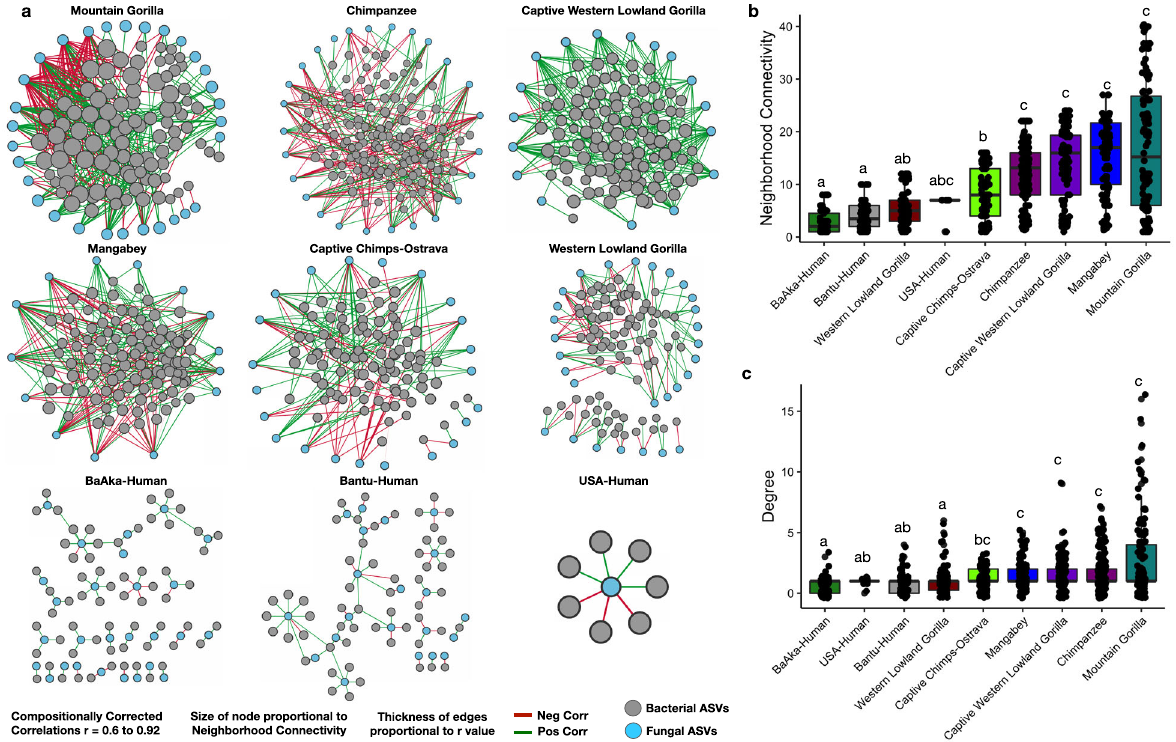
Fig. 4 Complexity of bacteriome-mycobiome co-occurrence networks varies among different primate groups. a Co-occurrence networks constructed using all signi fi cant correlations (compositionally corrected corrs r > + / − 0.6 and p < 0.01) showed clear distinctions in network complexity between human and nonhuman primates. Size of the node shows the number of connections of each fungal ASV. Color of nodes represents bacterial and fungal ASVs shown in Fig. 4a. Each symbol represents an individual primate species. Edge color represents negative (red lines) and positive (green lines) correlations respectively. Bacterial fungal co-occurrence network attributes ( b ) Neighborhood connectivity and ( c ) Degree shows a smaller number of bacterial fungal connections in all humans and in western lowland gorillas. Different letters denote signi fi cant differences according to Kruskal – Wallis tests. In boxplots, center values indicate the median; bounds of box represents lower/upper quartiles; whiskers show inner fences. The identi fi er used for primate groups are Mangabey: Agile Mangabeys and Chimps: